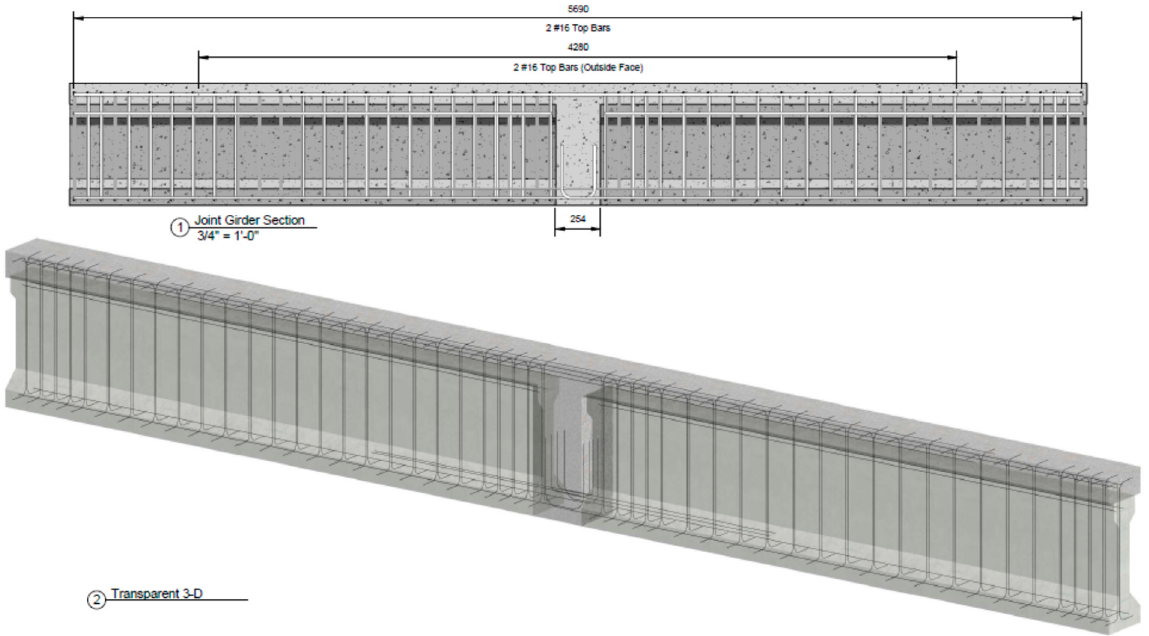
Figure 3. Fully constructed connected girder test specimen.